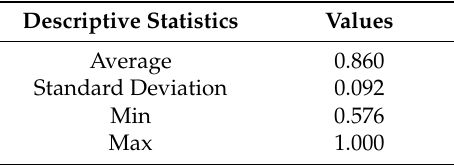
Table 2. DEA VRS efficiency